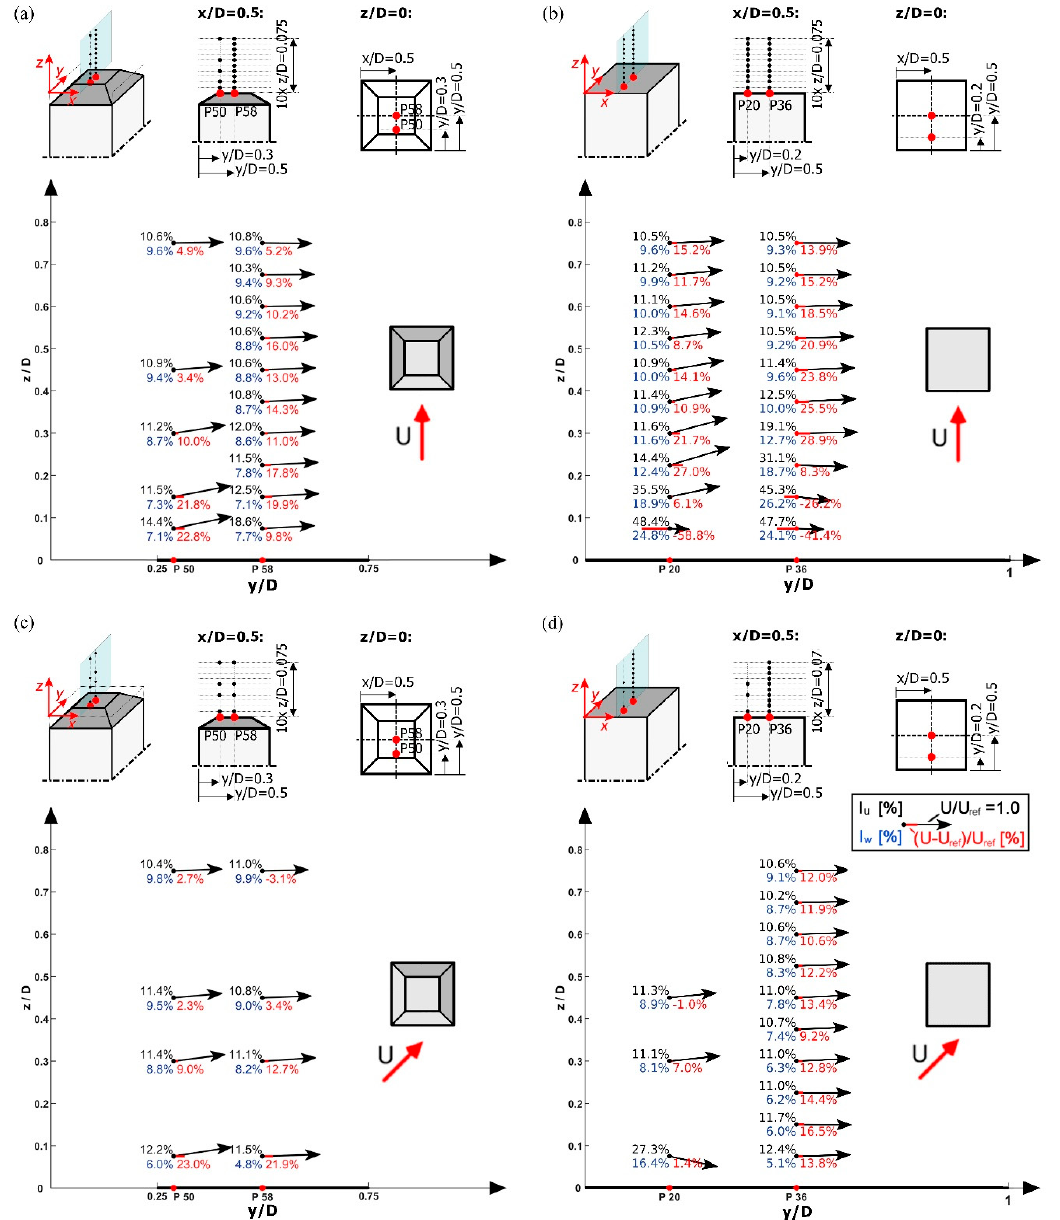
Figure 10. Velocity vectors profiles, based on the stream-wise and vertical velocity components, showing the stream-wise turbulence intensity I U , the vertical turbulence intensity I W and the percentage increase in the stream-wise wind speed. Each numerical value reported at every measurement point in the figure shows the following statistics: I U [%] above on the left; I W [%] below on the left; (U-U ref ) / U ref [%] below on the right. Profiles over the deck-roof high-rise building are measured above points 18 and 50 (alignment x / D = 0.2, left-hand-side), for wind directions of: ( a ) 0 ◦ and ( c ) 45 ◦ ; and over the flat-roof high-rise building above the points 20 and 36 ( x / D = 0.5), for wind directions of: ( b ) 0 ◦ and ( d ) 45 ◦ . The arrows indicate the velocity magnitude normalised with reference velocity ( U ref ), as referred to the unity vector represented in the